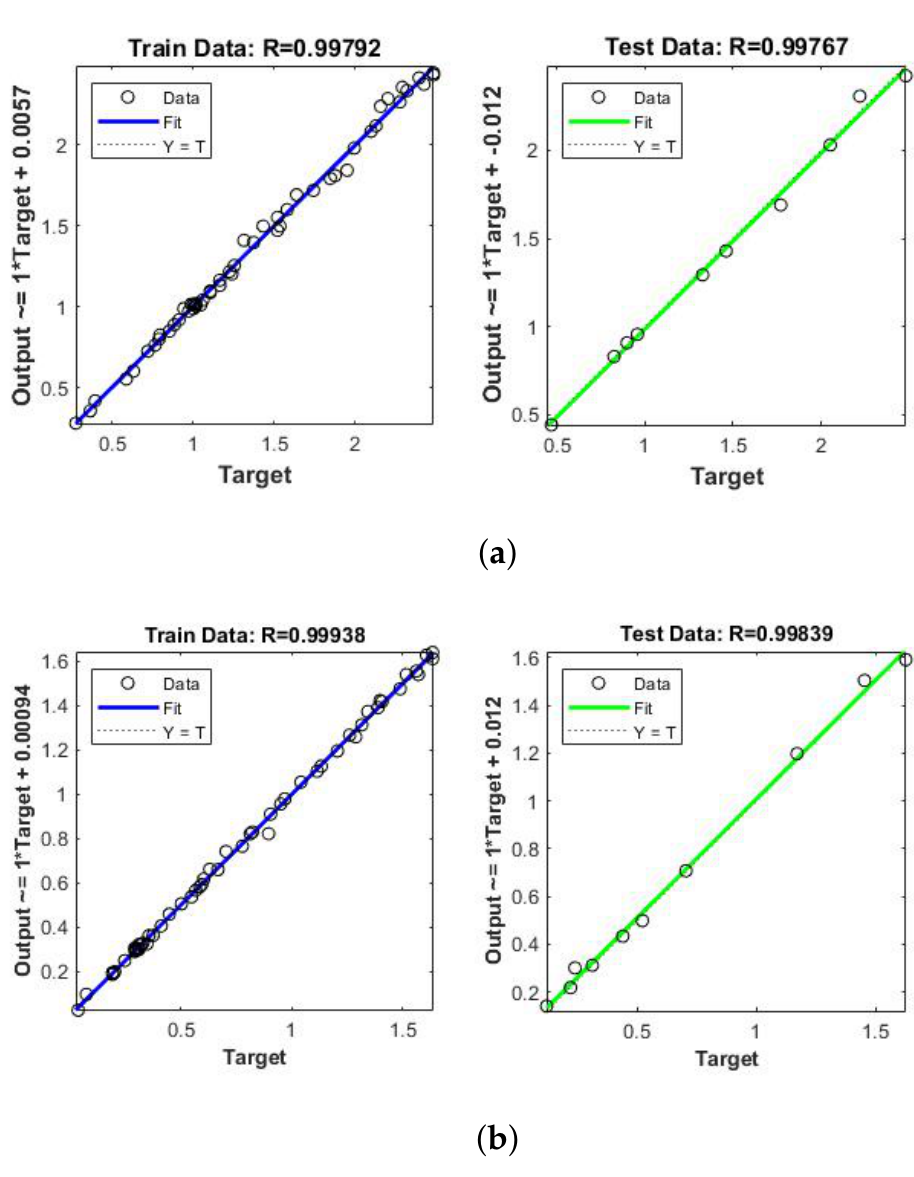
Figure 8. Validity test of SISO FIS models, using five MFs for inputs and output. ( a ) Temp–enzyme activity model performance using training data (blue) and test data (green). ( b ) pH–enzyme activity model performance using training data (blue) and test data (green).